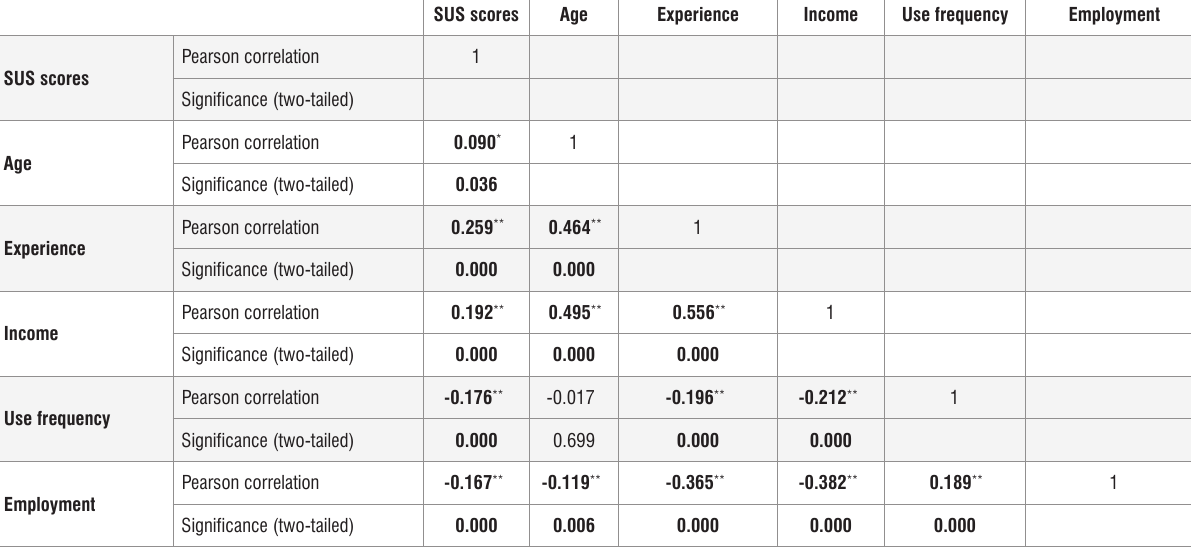
Table 6: Correlation analysis between system usability scale (SUS) scores and categorical variables SUS scores Age Experience